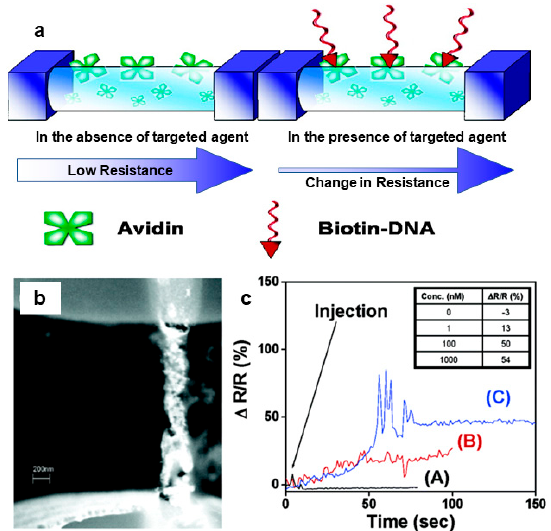
Figure 11. ( a ) Incorporation of some species, such as avidin, enables detection of other species, such as biotin, due to changes in conductivity/resistance. ( b ) Scanning electron micrograph of a 200-nm wide avidin-containing PPy nanowire. ( c ) While a PPy nanowire that does not contain avidin (A) shows no resistance change when biotin is added in 10 mM NaCl, avidin-containing PPy nanowires (B) and (C) exhibit a resistance change when biotin is added [52]. Reprinted with permission from K.